Question: In a single sentence, describe what this figure presents.
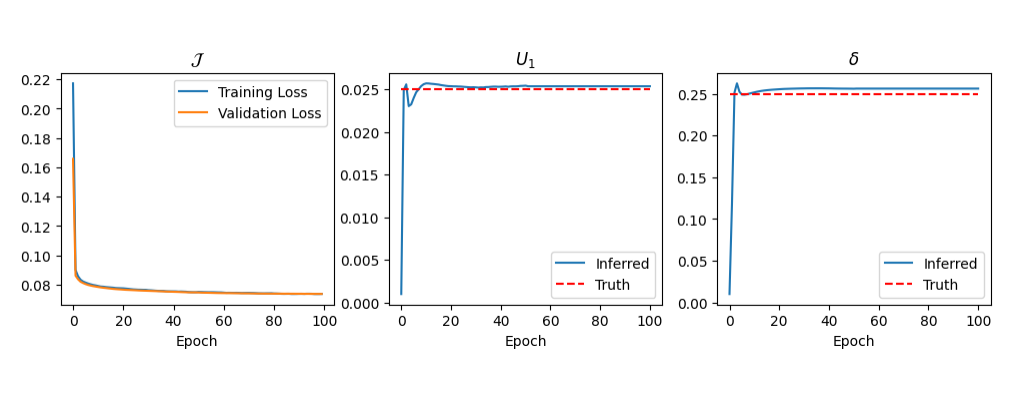
Answer: Curves for training loss, validation loss, U1 and δ. Note that the values are averaged over all the batches within an epoch. After 50 epoches, U1 and δ are fixed.